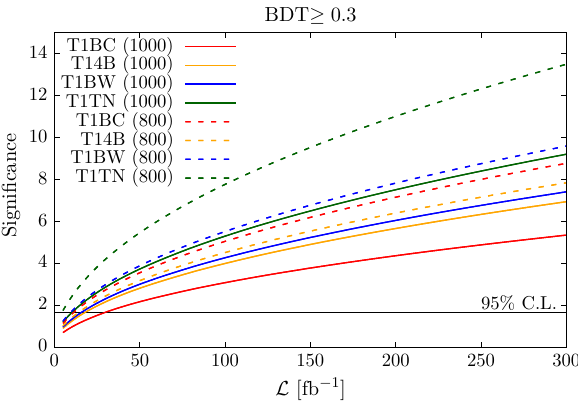
Fig. 6 The signal significance at different integrated luminosities, where the BDT cut is chosen as BDT ≥ 0 . 3. The horizontal line cor- responds to the 95% C.L. exclusion